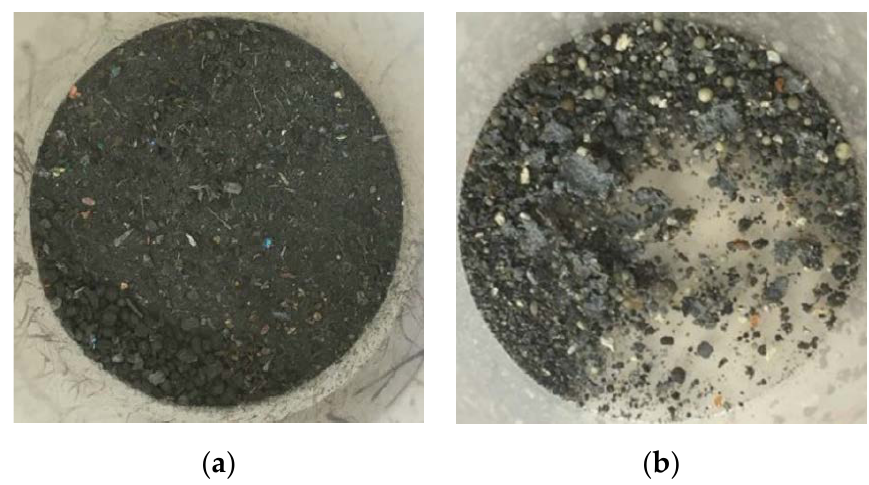
Figure 6. Images of ( a ) PCB analytical sample and ( b ) solid residue after digestion with United States Environmental Protection Agency (US EPA 3052) (method A1) (1.0:2.5, photos taken by author).